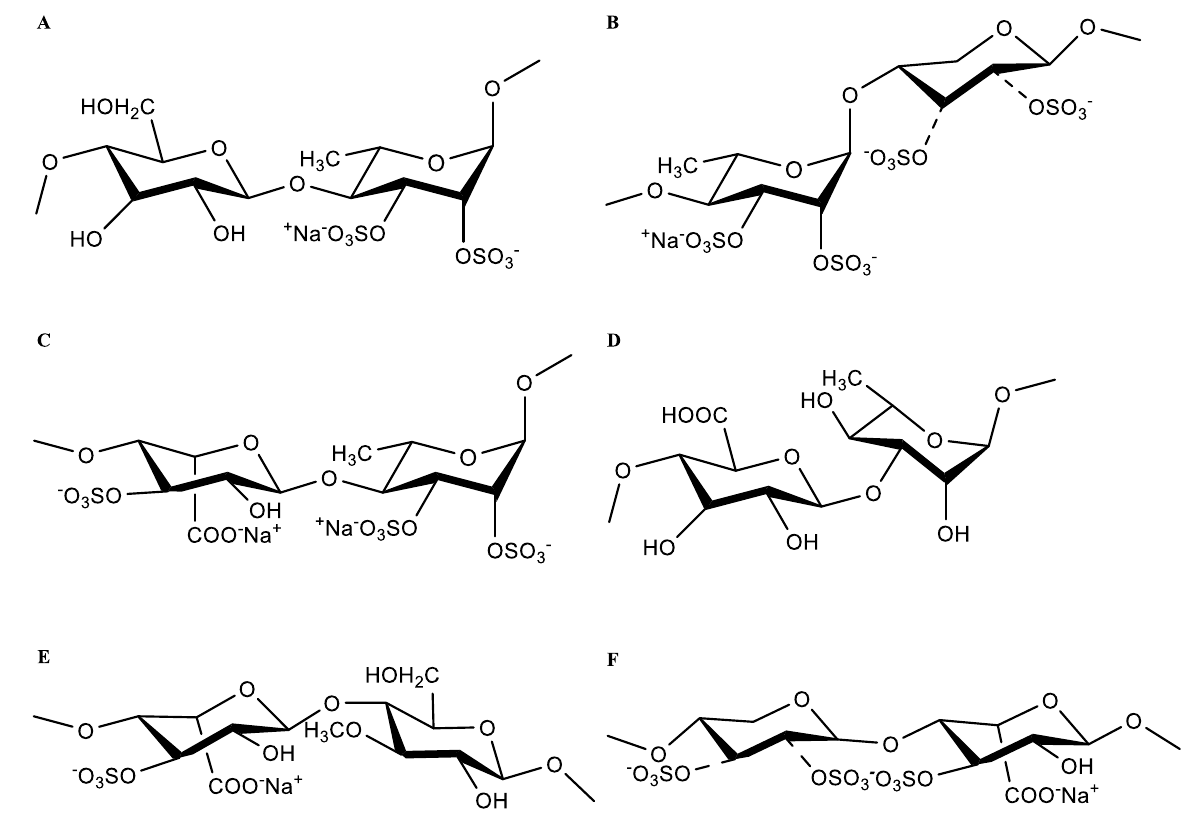
Figure 6. The main form of residues linkage of HU. ( A ) → 4)- β -D-Glcp(1 → 4)- α -L-Rhap2,3S(1 → . ( B ) → 4)- α -L-Rhap3S(1 → 4)- β -D-Xylp2,3S(1 → . ( C ) → 4)- α -L-IdopA3S(1 → 4)- α -L-Rhap3S(1 → . ( D ) → 4)- β -D-GlcpA(1 → 3)- α -L-Rhap(1 → . ( E ) → 4)- α -L-IdopA3S(1 → 4)- β -D-Glcp3Me(1 → . ( F ) → 4)- β -D-Xylp2,3S(1 → 4)- α -L-IdopA3S(1 → . OSO 3 : both positions 2 and 3 of xylose are substituted by sulphate, or one or neither